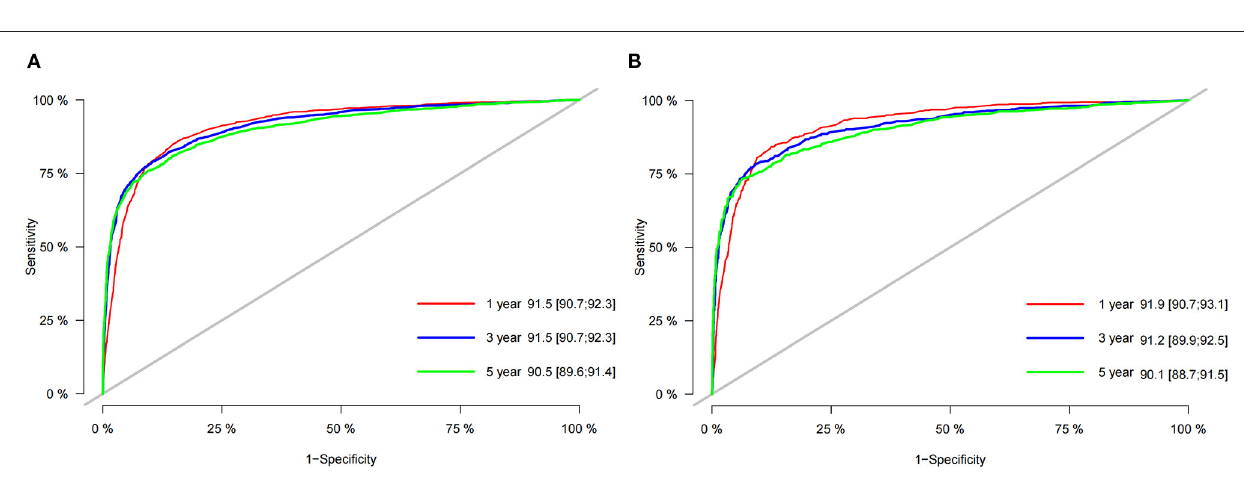
RCC and found that tumor size was an important risk factor